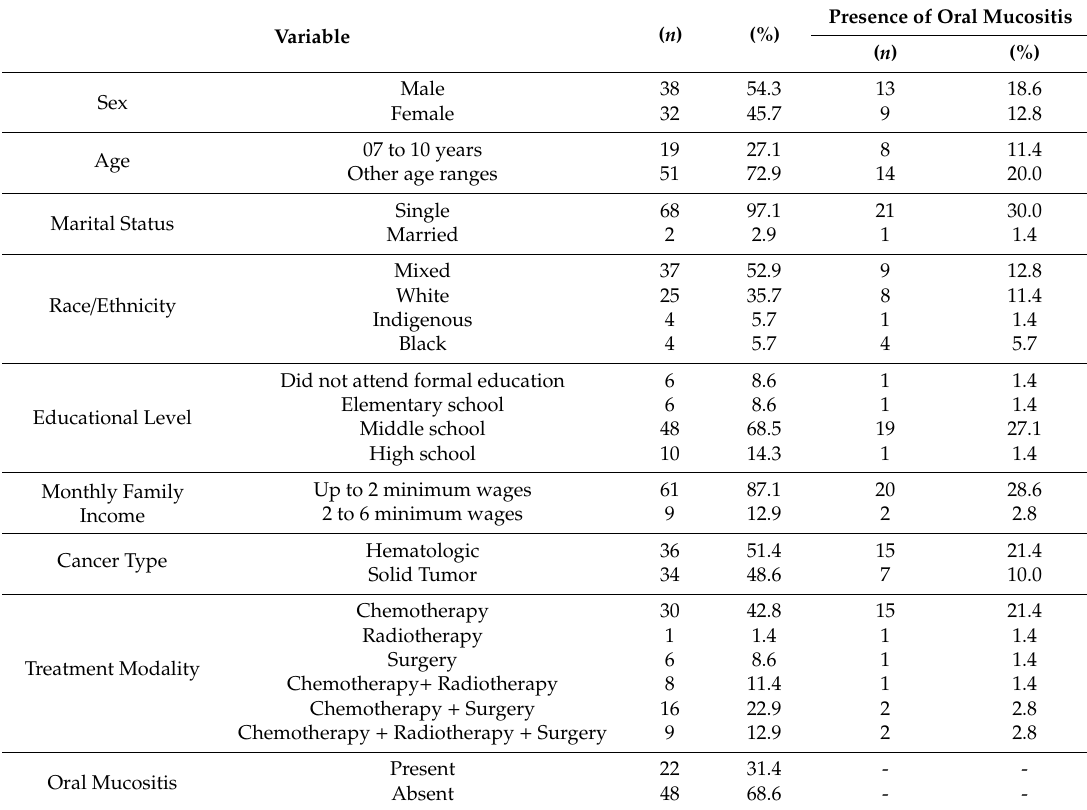
Table 1. General characteristics of the study sample. Jo ã o Pessoa, PB, Brazil, 2017.